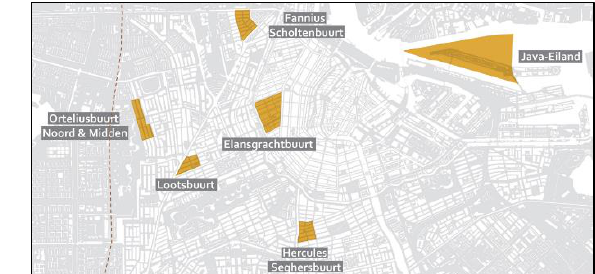
Figure 13. Selected reference neighbourhoods in Amsterdam.